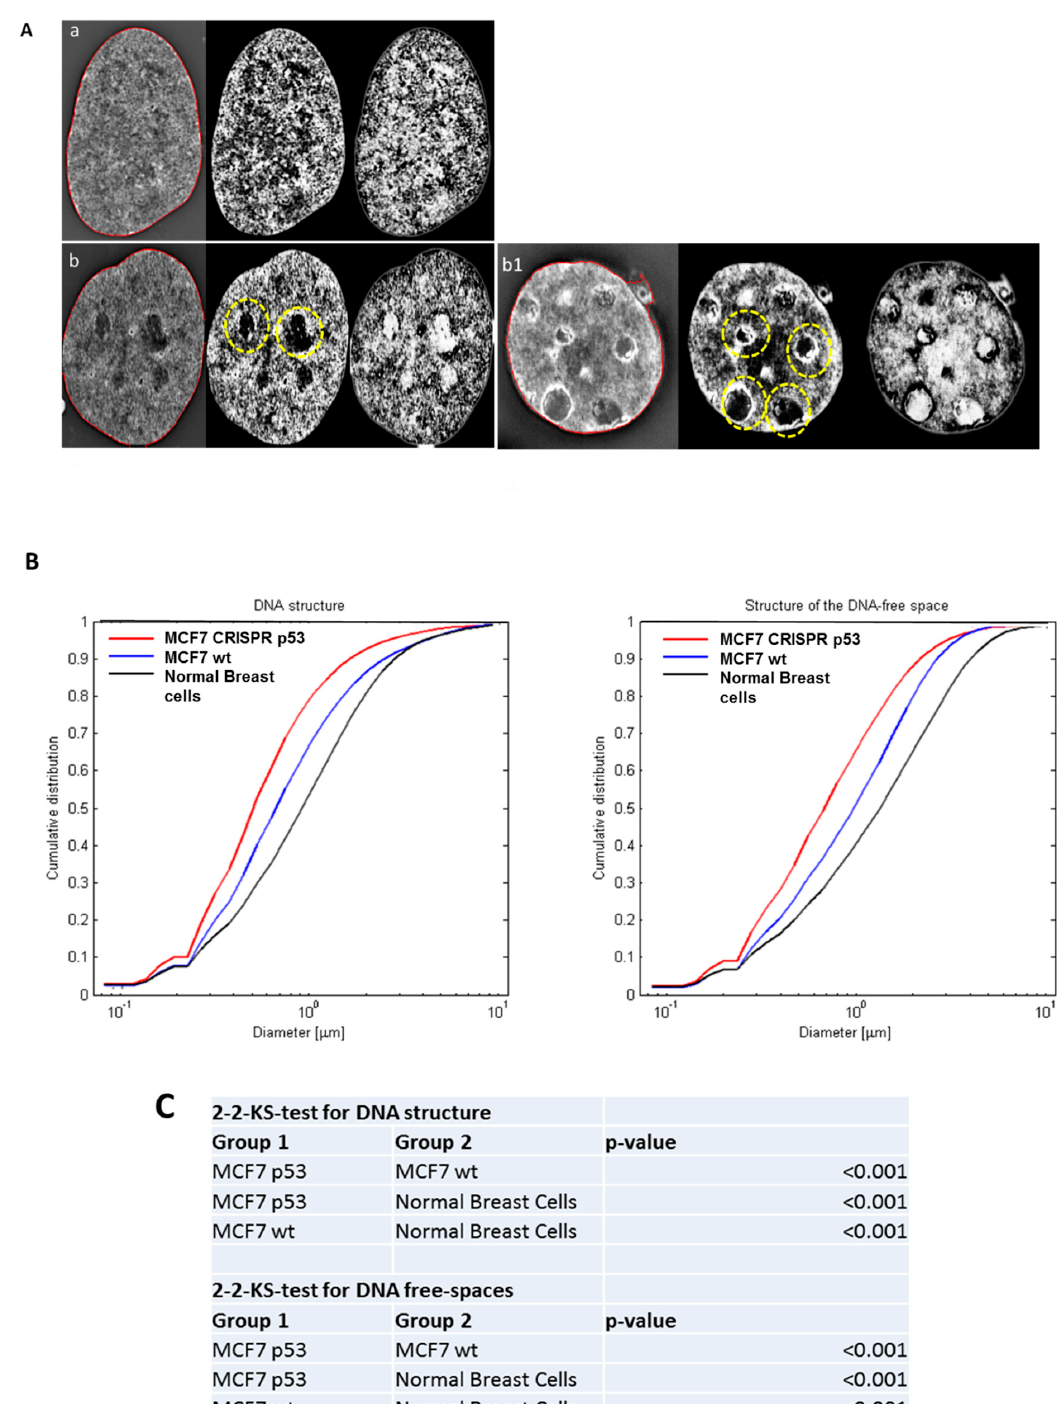
Figure 1. The use of three-dimensional (3D)-SIM (Structured Illumination Microscopy) to investigate di ff erences in DNA structure between normal breast cells, and MCF-7 (Michigan Cancer Foundation-7). ( A ) 3D-SIM images of primary normal breast cells (a), MCF7 wild type (b) and MCF7 CRISPR(Clustered Regularly Interspaced Short Palindromic Repeats) p53 deleted (b1). MCF7 shows more DNA-poor spaces than primary breast cells and CRISPR p53 deleted cell lines shows more DNA-poor spaces than the wild-type ones. Left panels: reconstructed 3D-SIM images; middle panels: light granulometry images; right panels: dark granulometry images. ( B ) Comparisons of granulometry DNA structure and DNA-poor spaces between the three cell lines. ( C ) p -value comparisons for the comparisons in